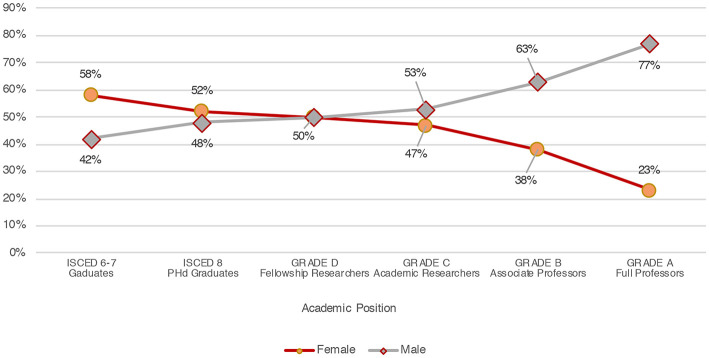
Proportion of men and women at each academic career step (Source: MIUR).